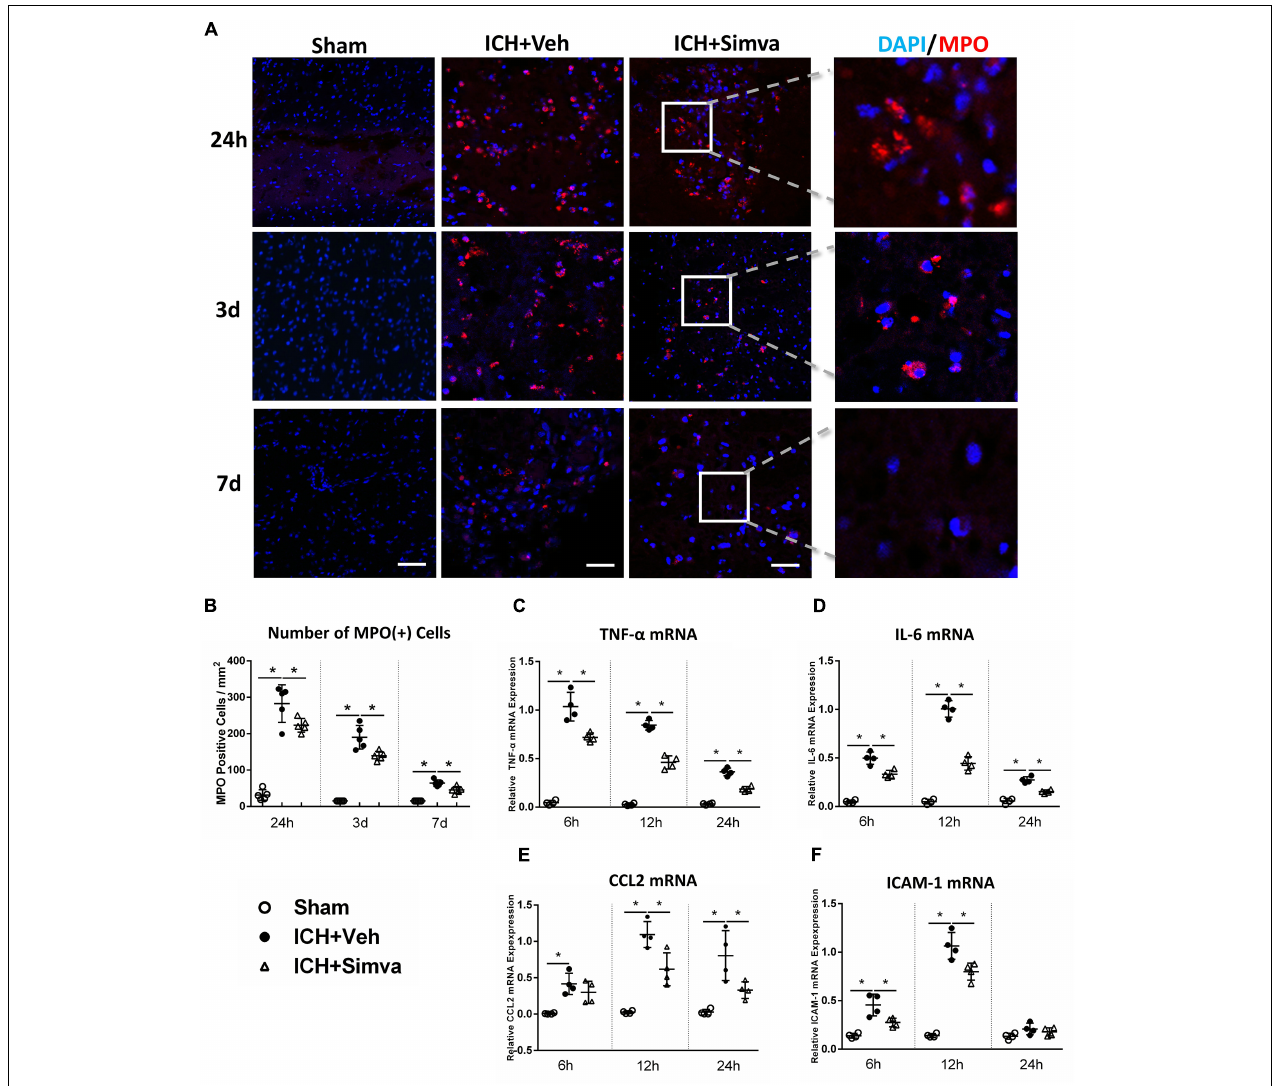
FIGURE 2 | Simvastatin significantly reduced brain-infiltrating PMNs and proinflammatory mediators expression in perihematomal area after ICH. (A) Representative images of MPO (+) immunofluorescence around hematoma 1, 3, and 7 days after ICH. (B) Perihematomal MPO positive cells count at the indicated time points. Values are expressed as mean ± SD , n = 6 per group; ∗ P < 0.05 versus sham group. RT-PCR analysis of TNF- α (C) , IL-6 (D) , CCL2 (E) , and ICAM-1 (F) mRNA in perihematomal tissue at 6, 12, and 24 h after ICH. Values are expressed as mean ± SD, n = 4 per group; ∗ P < 0.05 versus sham group. The scaling bar represents 20 µ